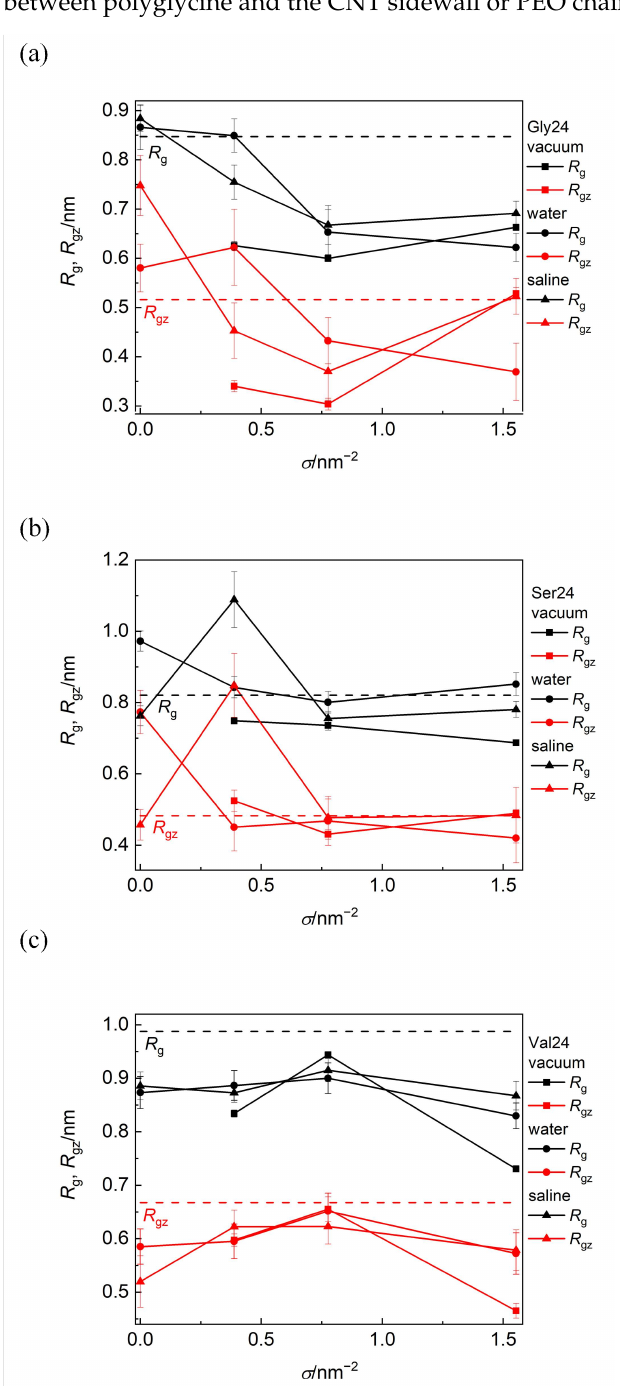
Figure 6. Radius of gyration, R g , and its component along the CNT axis, R gz , of polyglycine ( a ), polyserine ( b ), and polyvaline ( c ) as functions of grafting density in a vacuum, water, and saline. The black and red dashed lines represent the values of R g and R gz for free peptides in water,